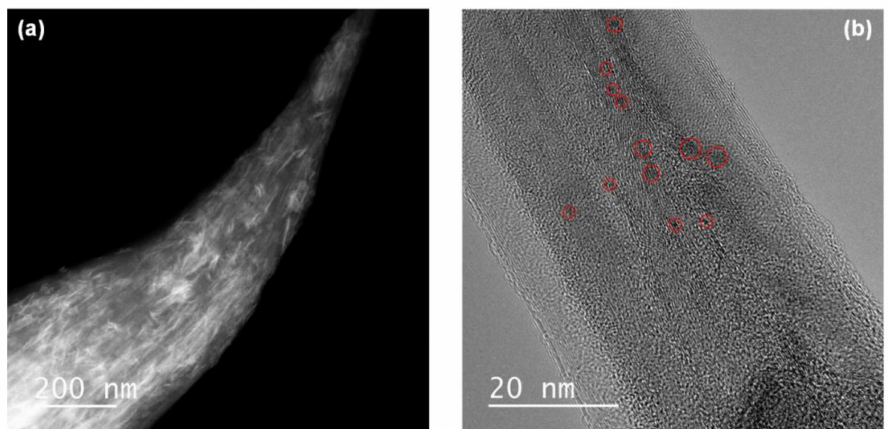
Figure 3. ( a ) ADF scanning TEM image of CNT–MnO 2 fiber (10, 8) showing that MnO 2 nanoflakes (bright contrast) were present along the CNT fiber. ( b ) High-resolution TEM image revealing that the size of the MnO 2 nanoflakes (some are marked by red circles) was approximately 2–3 nm.